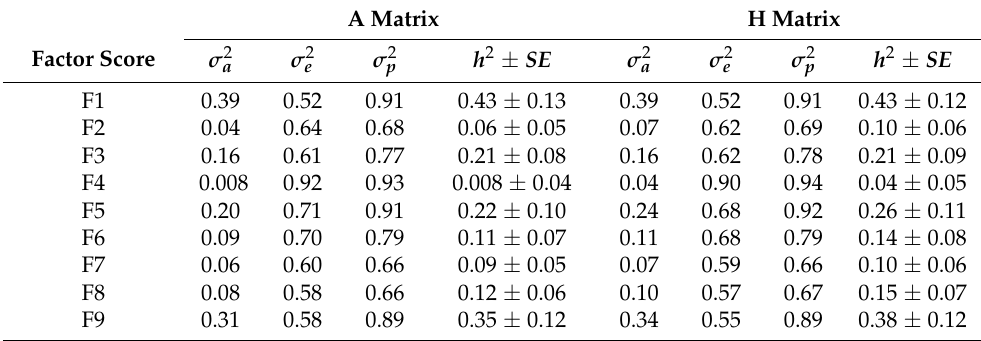
Table 5. Estimated variance components, heritability and standard errors for 9 factor scores obtained using the pedigree relationship matrix (A) and combined genomic-pedigree relationship matrix (H). A Matrix H Matrix